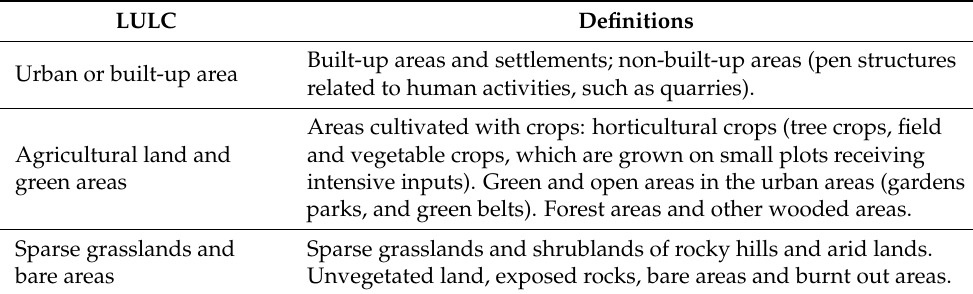
Table 2. Definitions of land use/land cover (LULC) categories in study area. LULC